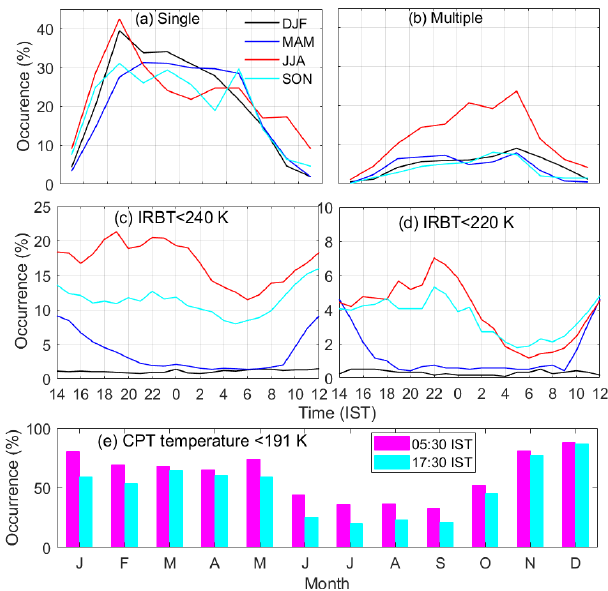
Figure 5. Diurnal variation in the percentage occurrence of (a) single-layer and (b) multilayer cirrus clouds, (c) an IRBT less than 240K, and (d) an IRBT less than 220K during different sea- sons over the period from 2016 to 2018. (e) The monthly percent- age occurrence of a CPT temperature less than 191K at 05:30 and 17:30IST over the 2016–2018